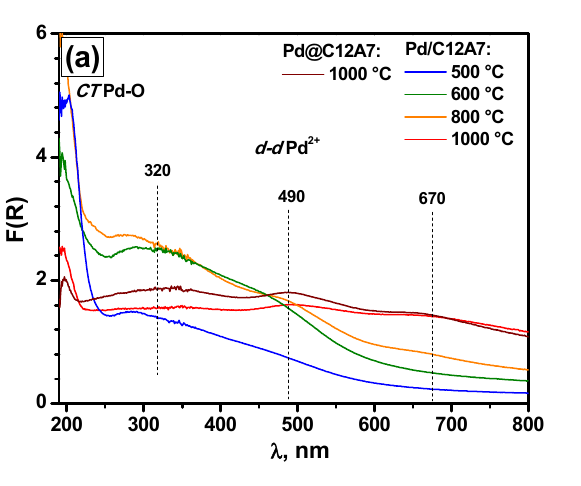
Figure 10. Diffuse reflectance UV–Vis spectra for the Pd/C12A7 sample consecutively calcined in the range of 500 to 1000 ◦ C and the Pd@C12A7 sample after catalytic tests in the PTA mode ( a ). Dependencies of ( F(R) · E ) 2 on photon energy E characteristic of band-gap ( E g ) values for direct allowed transitions for Pd/C12A7 after catalytic tests in the PTA mode ( b